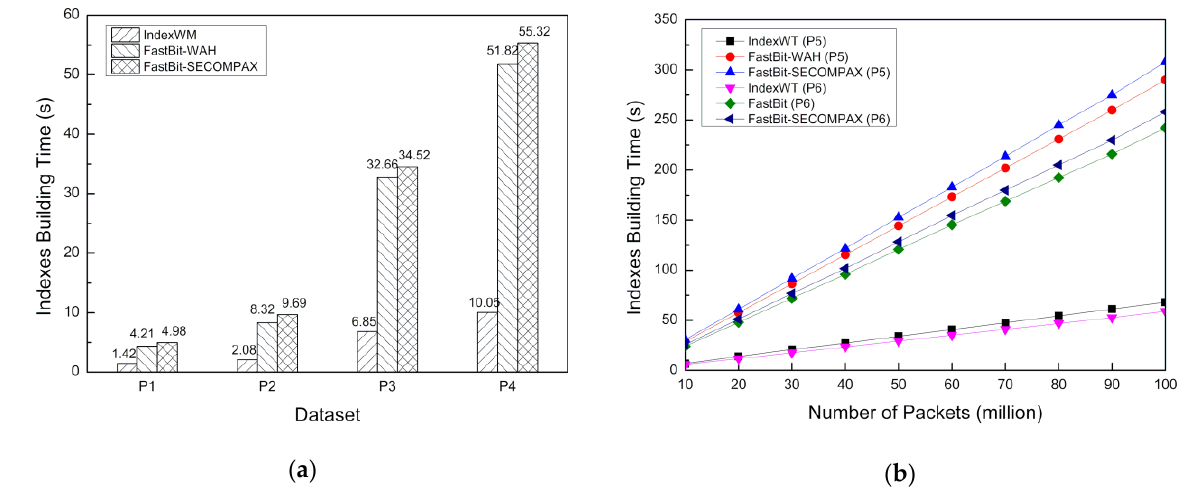
Figure 9. A comparison of time consumption for indexing. ( a ) Time consumption on datasets P1, P2, P3 and P4; ( b ) time consumption on datasets P5 and P6 as a function of the number of packets.